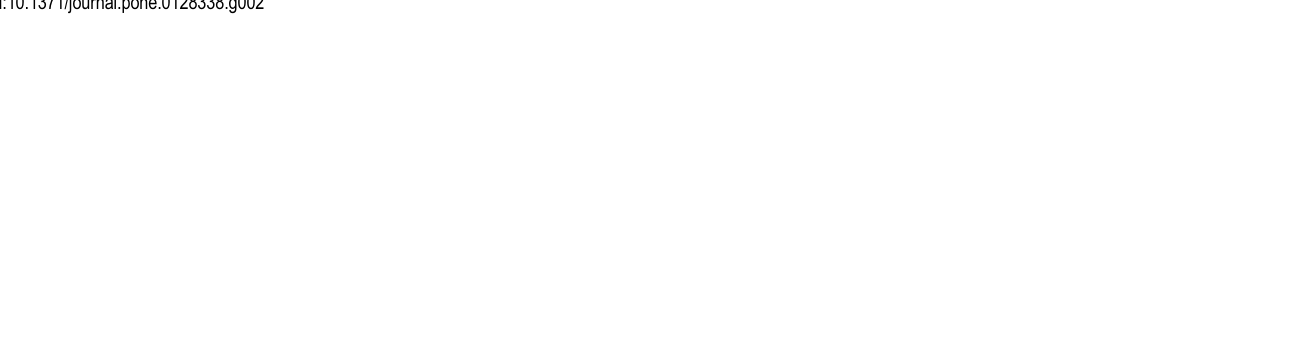
PLOS ONE | DOI:10.1371/journal.pone.0128338 June 17,